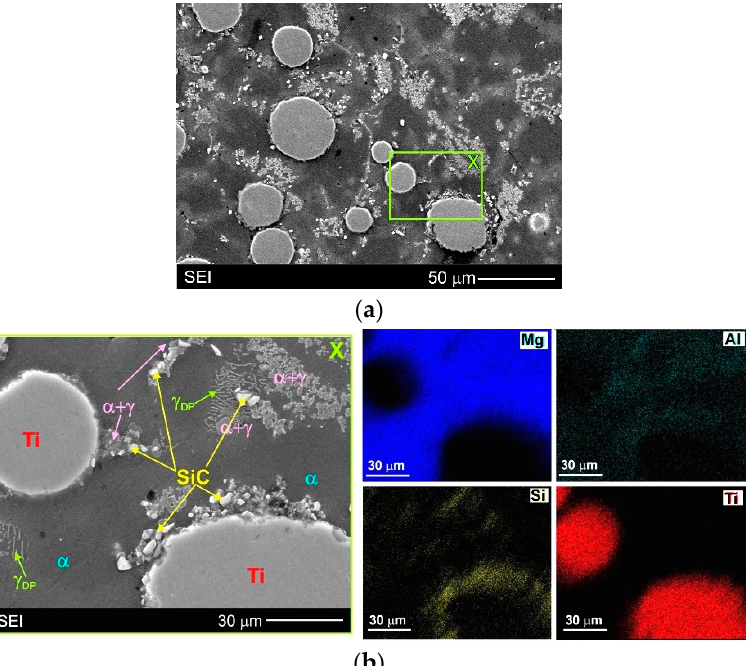
Figure 7. Microstructure of AZ91/(SiC + Ti) p hybrid composite: ( a ) SEM micrograph; ( b ) Higher magnification of area marked as X on ( a ) micrograph with EDX results in form of surface distribution of main elements (magnesium, aluminium, silicon and titanium).